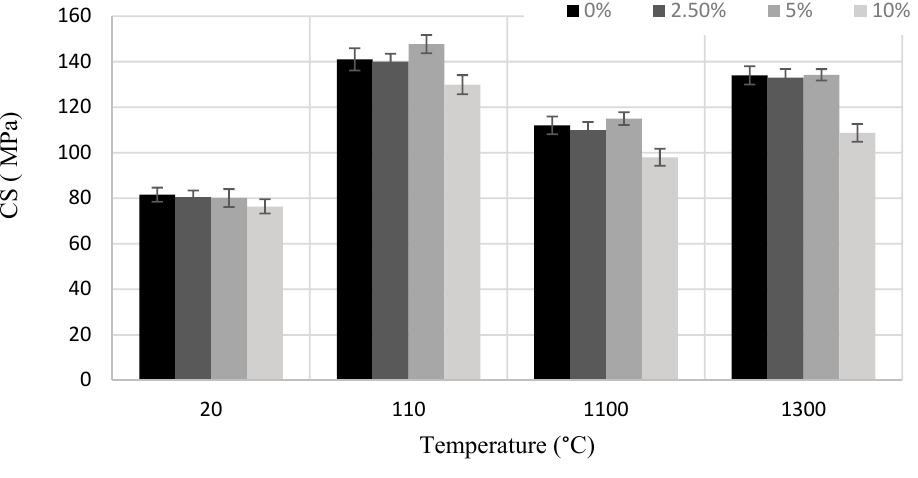
Figure 3. Dependence of compressive strength (CS) of the castable on the amount of HCM and tem ‐ perature.